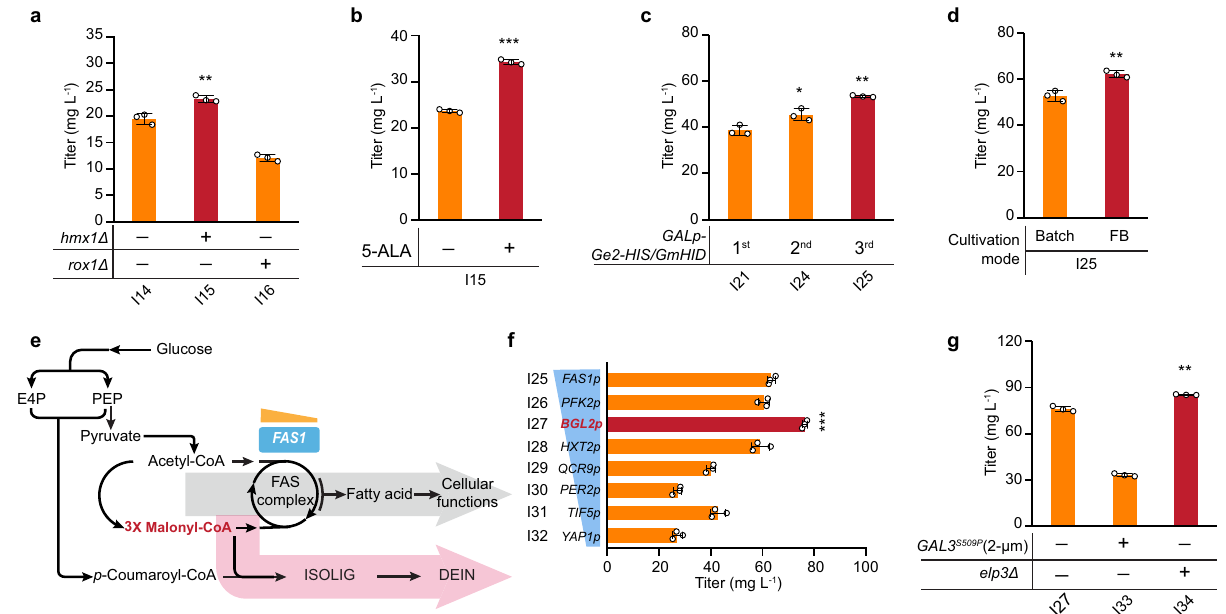
Fig. 6 Combinatorial optimization to increase the production of DEIN. a Effect of deleting genes involved in the regulation of heme metabolism on DEIN biosynthesis. Production of DEIN by strains fed with the heme biosynthetic precursor 5-ALA ( b ) or expressing different copies of Ge2-HIS and GmHID genes ( c ). d Process optimization for DEIN production. Cells were grown in a de fi ned minimal medium with 30 g L − 1 glucose (batch) or with six tablets of FeedBeads (FB) as the sole carbon source and 10 g L − 1 galactose as the inducer. Cultures were sampled after 72 h (batch) or 90 h (FB) of growth for metabolite analysis. e Schematic view of the interplay between iso fl avonoid biosynthesis and yeast cellular metabolism connected by the branchpoint malonyl-CoA. See Fig. 1 and its legend regarding abbreviations of metabolites and gene details. f Fine-tuning the expression of gene FAS1 via promoter engineering improves DEIN formation under optimized cultivation conditions. g Effect of genetic modi fi cations altering the regulation of GAL induction on DEIN production under optimized cultivation conditions. The constitutive mutant of galactose sensor Gal3 ( GAL3 S509P ) was overexpressed from a multi- copy plasmid (2 µ m) under the control of GAL10p and gene ELP3 , encoding a histone acetyltransferase, was deleted. Cells were grown in a de fi ned minimal medium with six tablets of FB as the sole carbon source and 10 g L − 1 galactose as the inducer. Cultures were sampled after 90 h of growth for metabolite detection. Statistical analysis was performed by using Student ’ s t test (two-tailed; two-sample unequal variance; * p < 0.05, ** p < 0.01, *** p < 0.001). All data represent the mean of n = 3 biologically independent samples and error bars show standard deviation. The source data underlying panels ( a − d ) and ( f , g ) are provided in a Source Data fi